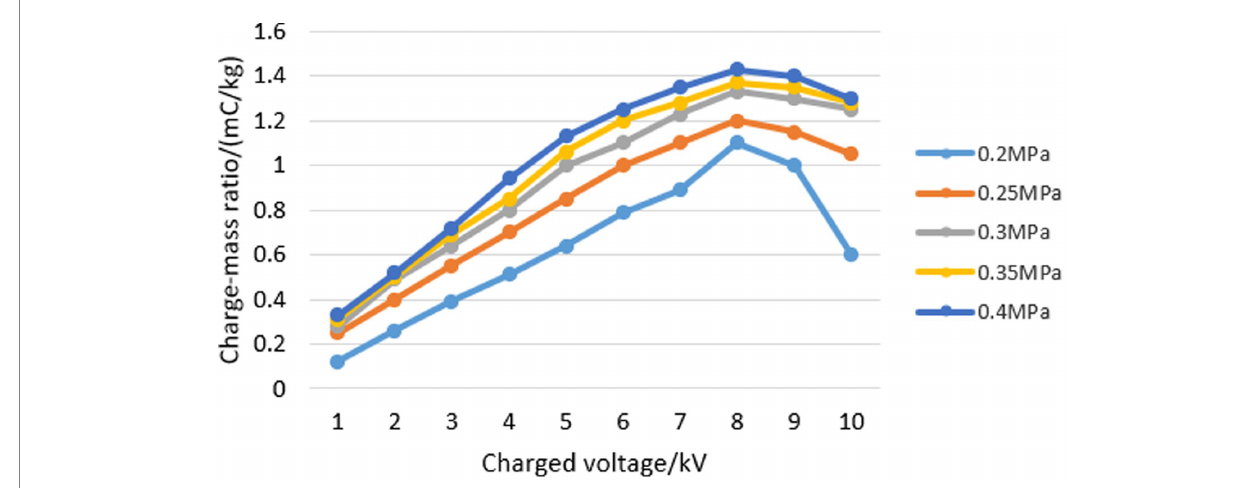
FIGURE 7 Experimental results of the effect of charging voltage on charge mass ratio.